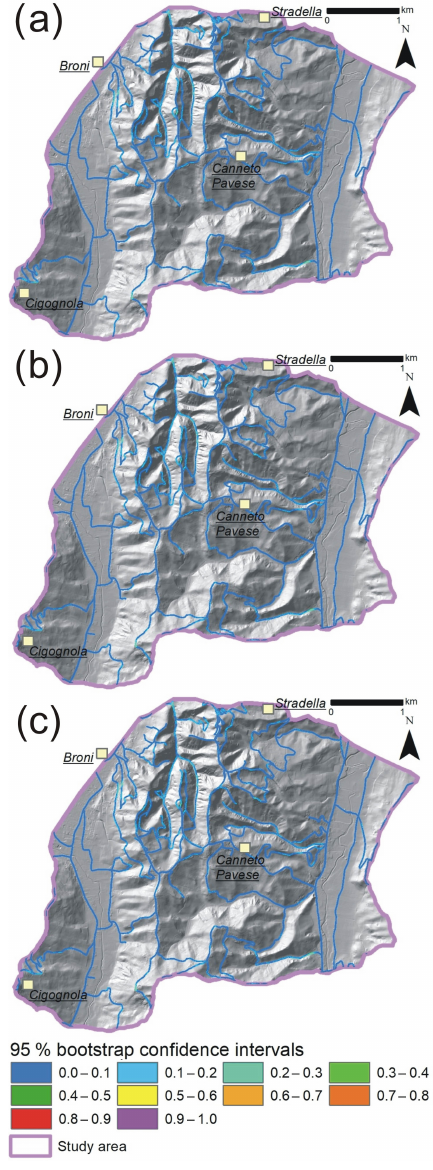
Figure 9. Maps of the amplitude of 95% bootstrap confidence inter- vals of the probability associated to each pixel of the studied area: (a) Model 1; (b) Model 2 and (c) Model